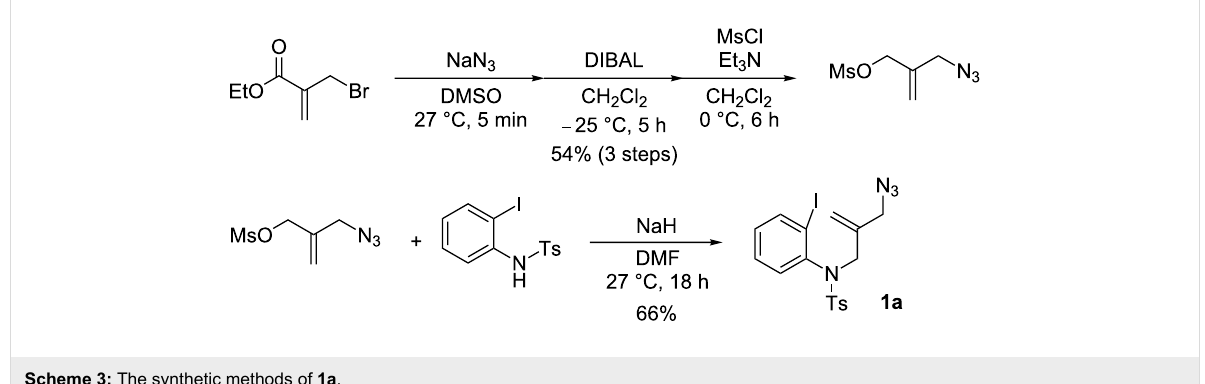
Scheme 3: The synthetic methods of 1a .